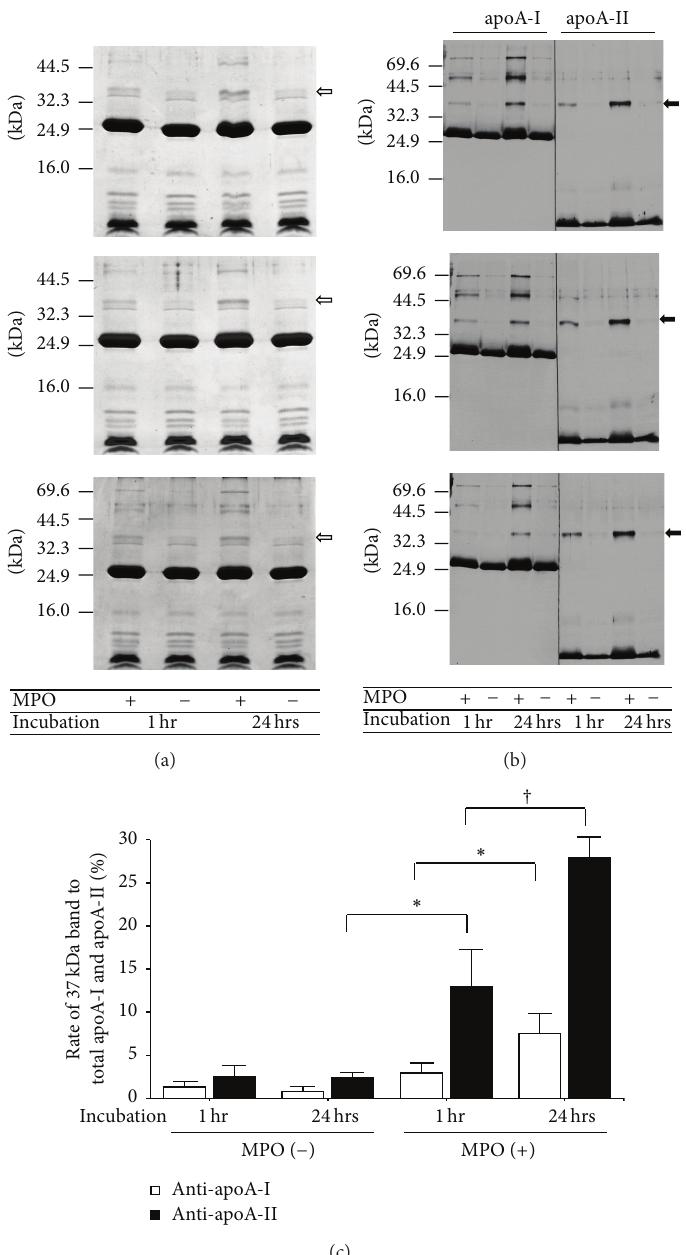
Figure 1: Apolipoprotein profiles of HDL treated with and without MPO. HDL treated with (+) or without ( − ) myeloperoxidase (MPO) for 1 and 24 hrs was subjected to SDS-PAGE followed by staining with Coomassie Brilliant Blue (a) and by immunoblotting for apoA-I and apoA-II (b). The 37 kDa bands, defined as apoA-I/apoA-II heterodimer, on CBB stained gel were indicated by white arrows. The bands that reacted with both anti-apoA-I and anti-apoA-II antibodies were identified as apoA-I/apoA-II heterodimers (black arrow). The molecular masses of standards are listed on the left. The ratios of apoA-I in apoA-I/apoA-II heterodimer to total apoA-I and apoA-II in apoA-I/apoA-II heterodimer to total apoA-II were estimated from immunoblotting patterns using a CS Analyzer (c). ∗ 𝑃 < 0.05 , † 𝑃 < 0.01 .